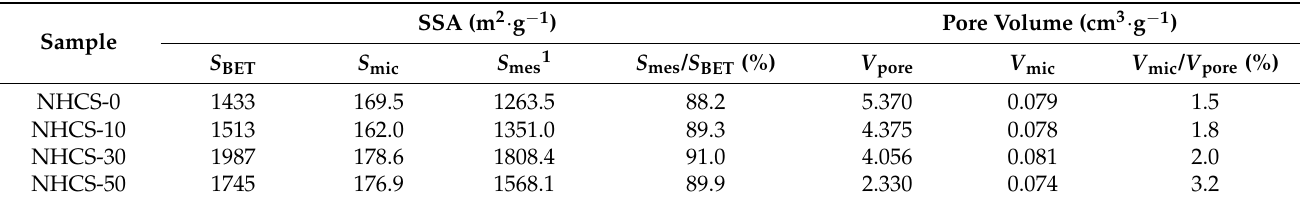
Figure 2. FE-SEM images of NHCS- m at ( a – d ) low-magnification and ( e – h ) high-magnification; TEM images of NHCS- m at ( i – l ) low-magnification and ( m – p ) high-magnification. ( a , e , i , m ) NHCS-0; ( b , f , j , n ) NHCS-10; ( c , g , k , o ) NHCS-30; and ( d , h , l , p ) NHCS-50. Table 1. Specific surface area (SSA) and pore structure parameters of NHCS- m